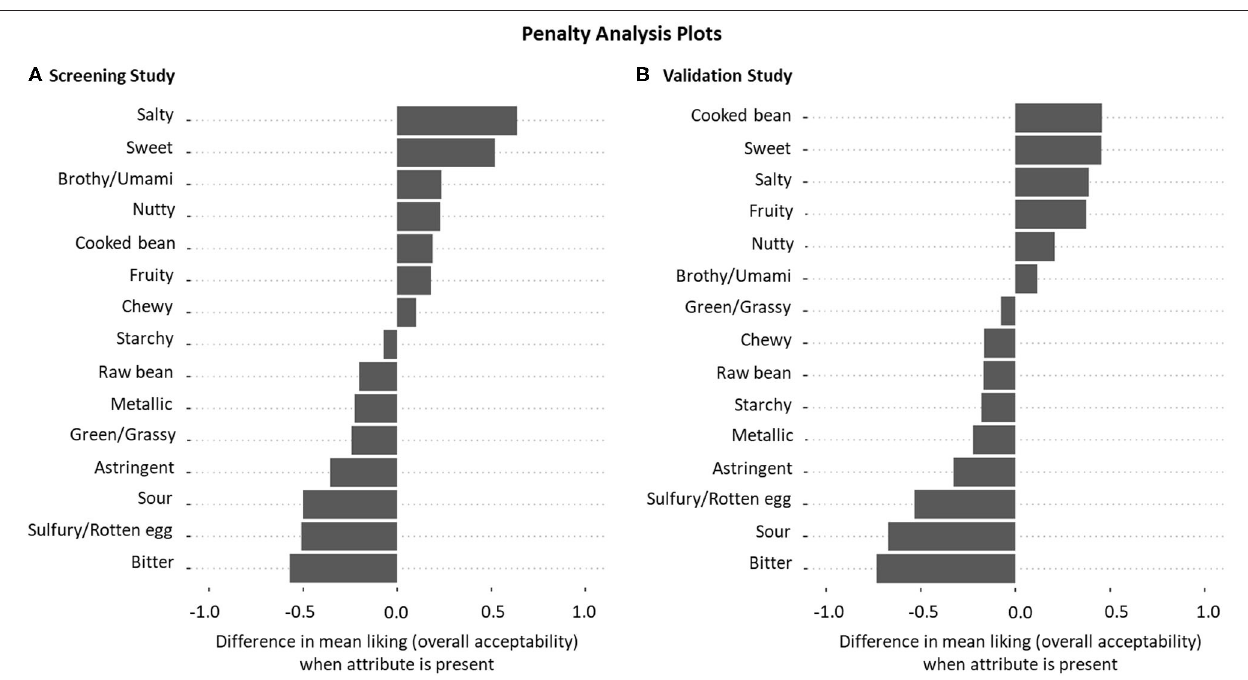
blanching. Our experimental blanching was the same for